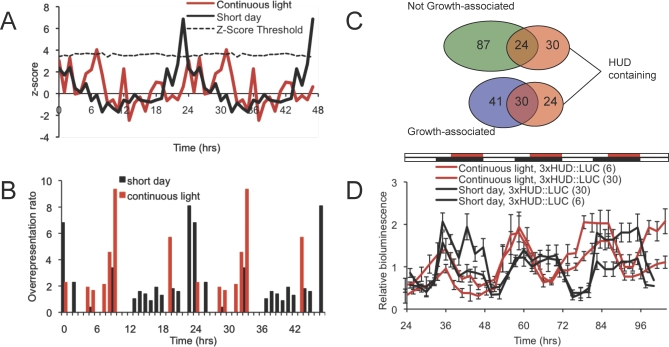
The HUD Motif (CACATG) Confers Diurnal and Circadian Regulation(A) The HUD motif (CACATG) is overrepresented in promoter of cycling genes expressed (Z-score, significance score) at midday under continuous light (red) and dawn under short-day photocycles (black) [19]. The Z-score profile is double plotted for visualization purposes. Black dotted line is the Z-score significance threshold (p < 0.05).(B) Phase overrepresentation of the 54 phytohormone genes with one or more HUD in their promoter (500 bp) under short-day photocycles (black) or continuous light (red).(C) Venn diagram of the 54 phytohormone genes with at least one HUD in their promoter (500 bp) and either the genes that are not growth associated (111 genes, green) or are growth associated (71 genes, blue).(D) Two independent T3 lines (6 and 30) carrying three tandem HUD repeats fused to LUC and a minimal promoter confer night-specific activity under short-day photocycles (black lines) and evening-specific activity under continuous conditions (red lines). Data represent the average of four to six seedlings from two independent experiments. Error bars represent standard error of the mean.